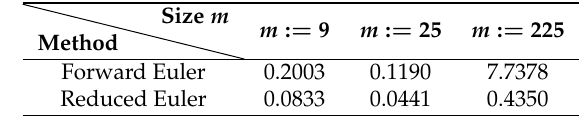
Table 4. Results of a comparison between the runtimes (in seconds) for the forward Euler method and for the reduced Euler